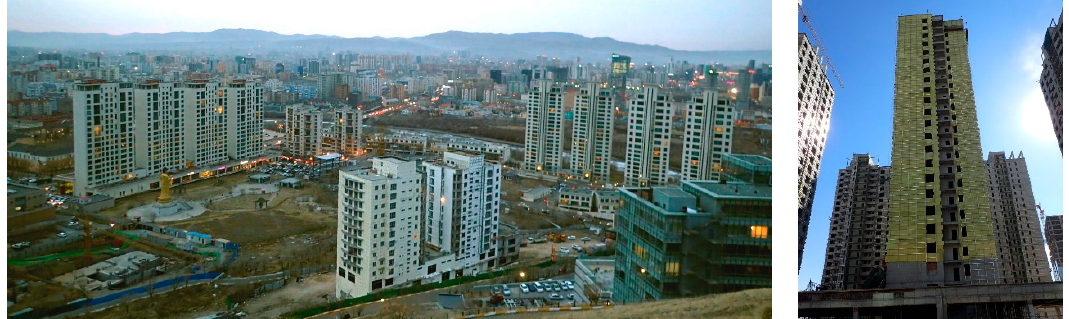
Figure 13. Photographs of newly constructed high-rise buildings in Zone-V. ( Left : taken by authors on 20 March 2018, Right : taken on 14 March 2019).